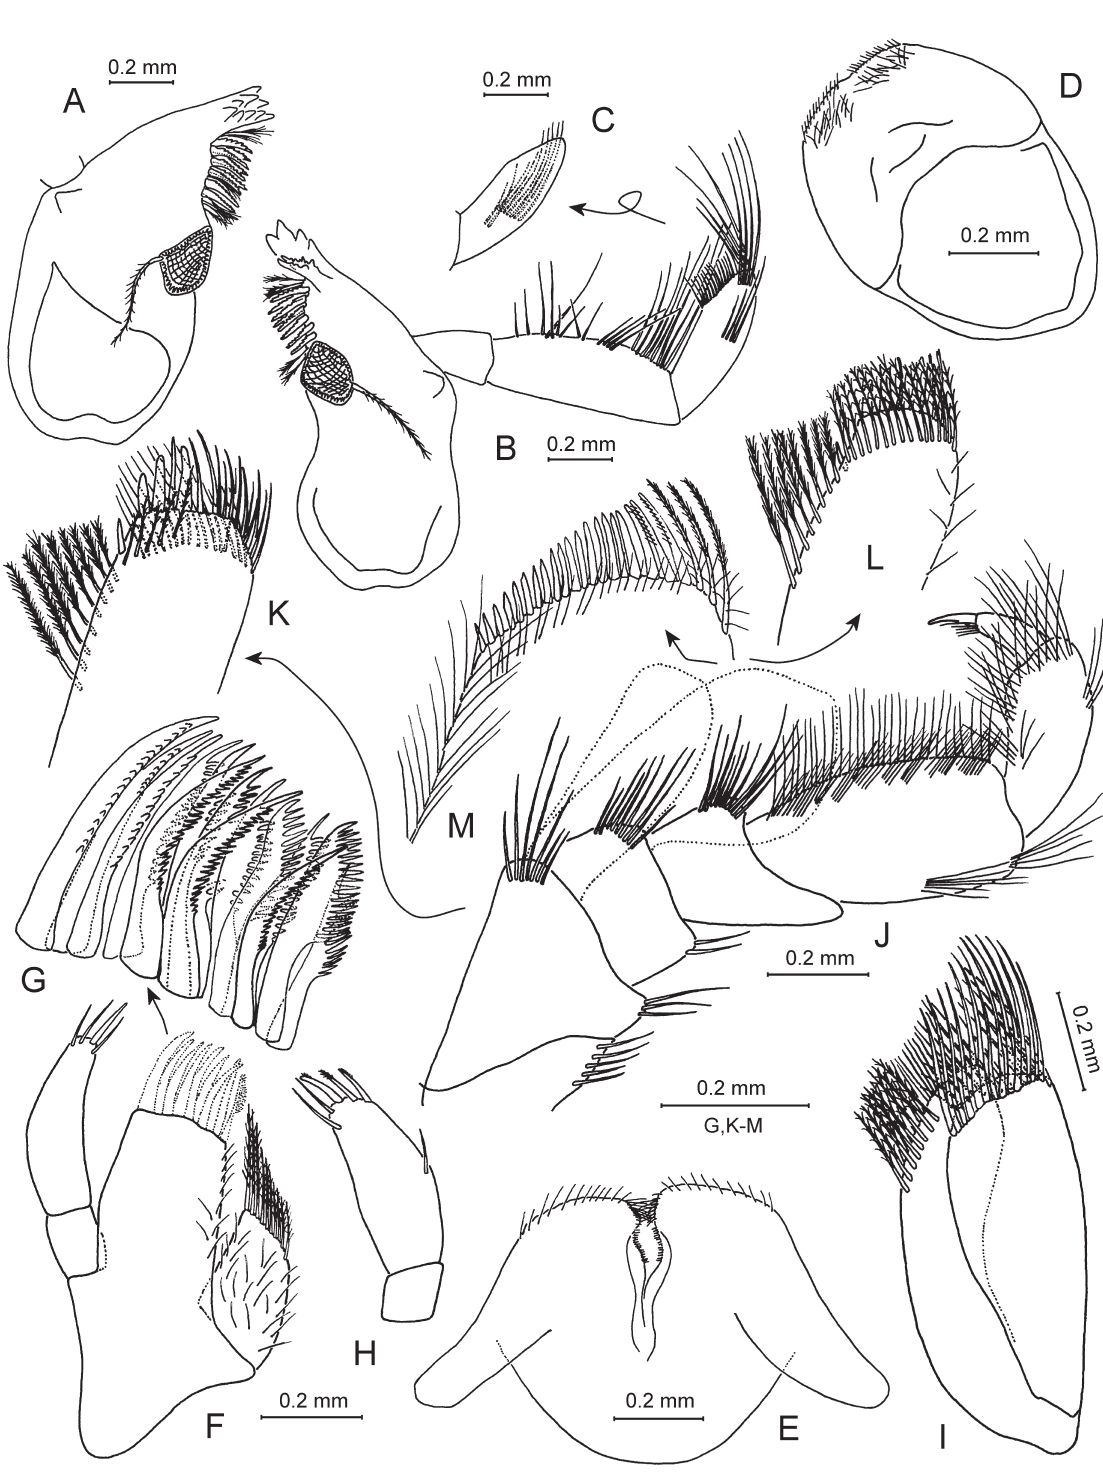
Fig. 13. Adaugammarus pilosus gen. et sp. nov. Holotype, ♀, 13.5 mm, X44046/Cr-1652-FEFU. A . Left mandible. B . Right mandible. C . Article 3 of mandibular palp, ventral setation. D . Upper lip. E . Lower lip. F . Maxilla I. G . Outer plate of maxilla 1. H . Palp of right maxilla 1. I . Maxilla 2. J . Maxilliped. K . Inner plate of maxilliped, inner face. L . Inner plate of maxilliped, outer face. M . Outer plate of